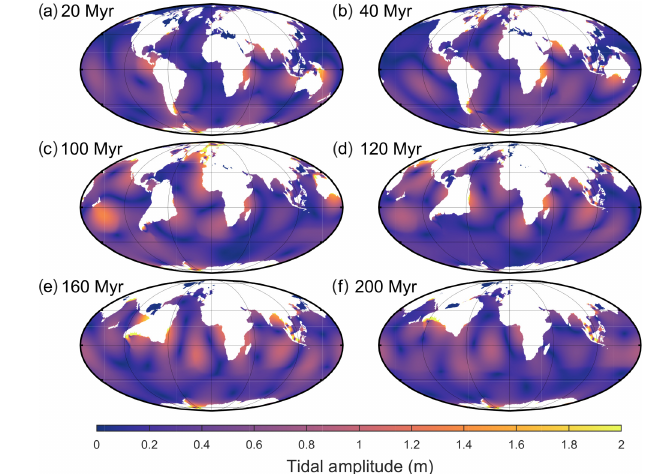
Figure 6. The same as in Fig. 2 but for the Amasia